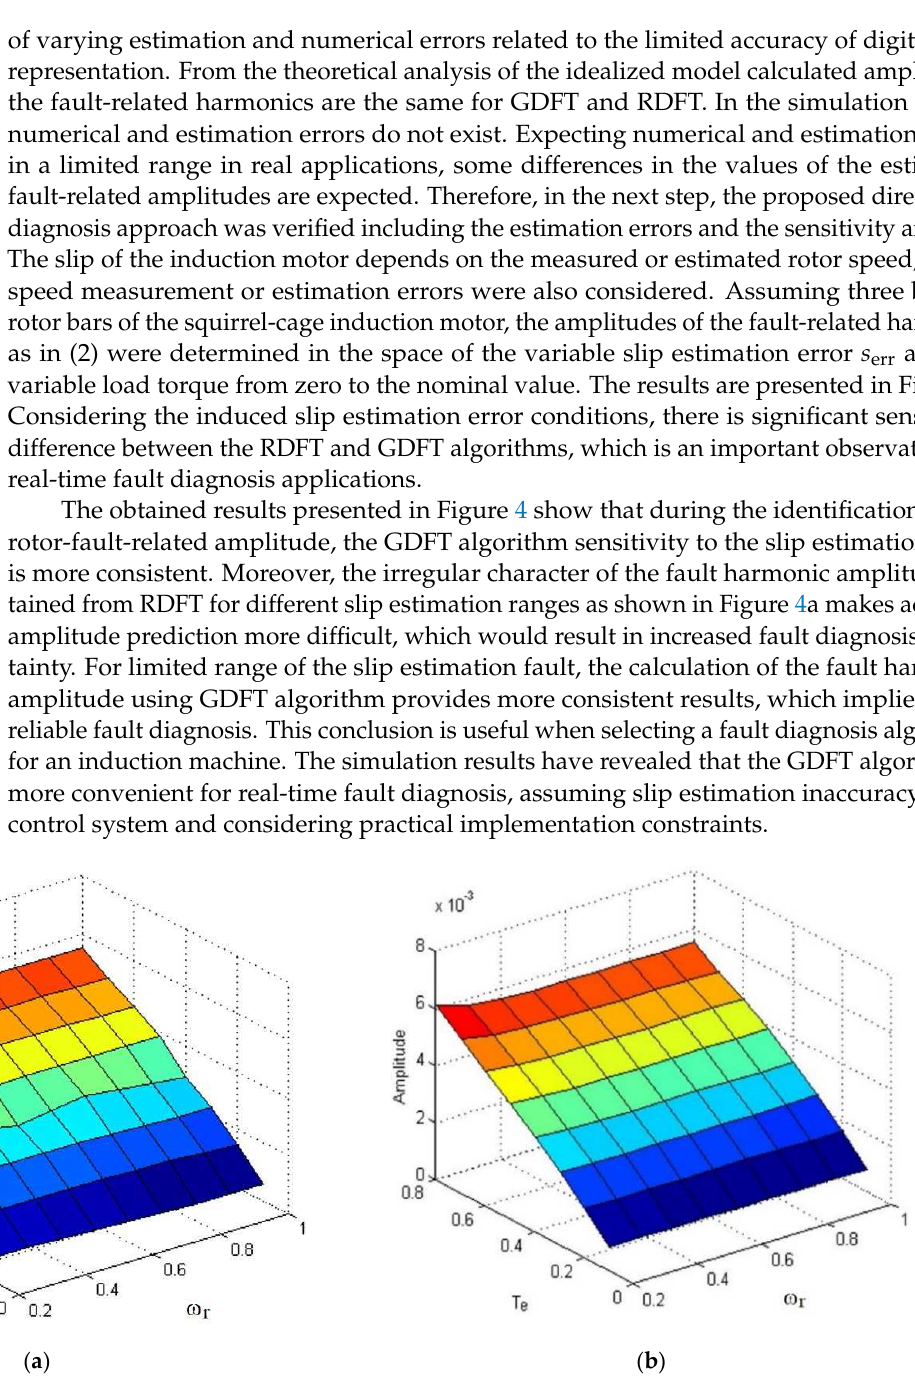
Figure 2. The amplitude of the rotor fault related harmonic obtained using ( a ) RDFT and ( b ) Goertzel’s algorithm for variable number of broken rotor bars and variable electromagnetic torque and rotor speed, with no slip estimation error assumed.